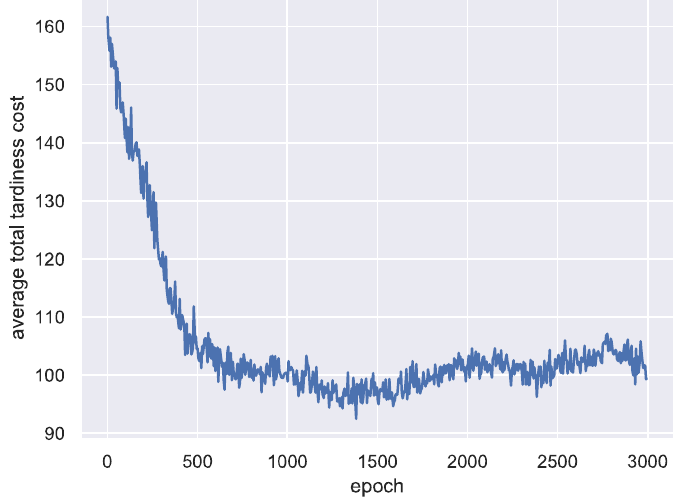
Figure 2. Average total tardiness cost on all test instances at each training epoch.